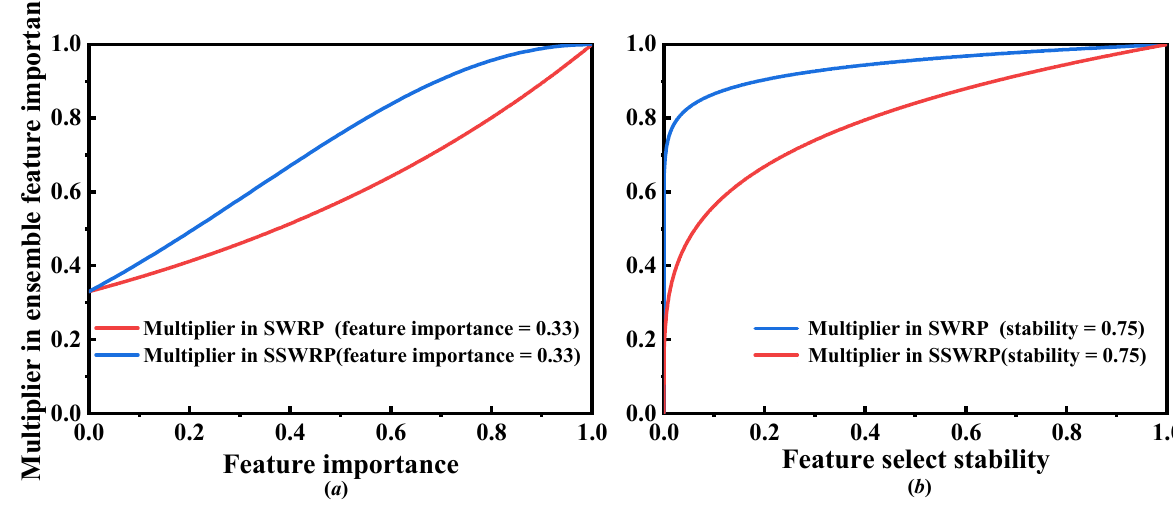
Figure 4. Multiplier comparison of ensemble feature importance between SSWRP and SWRP. ( a ) Feature important = 0.33. ( b ) stability = 0.75.